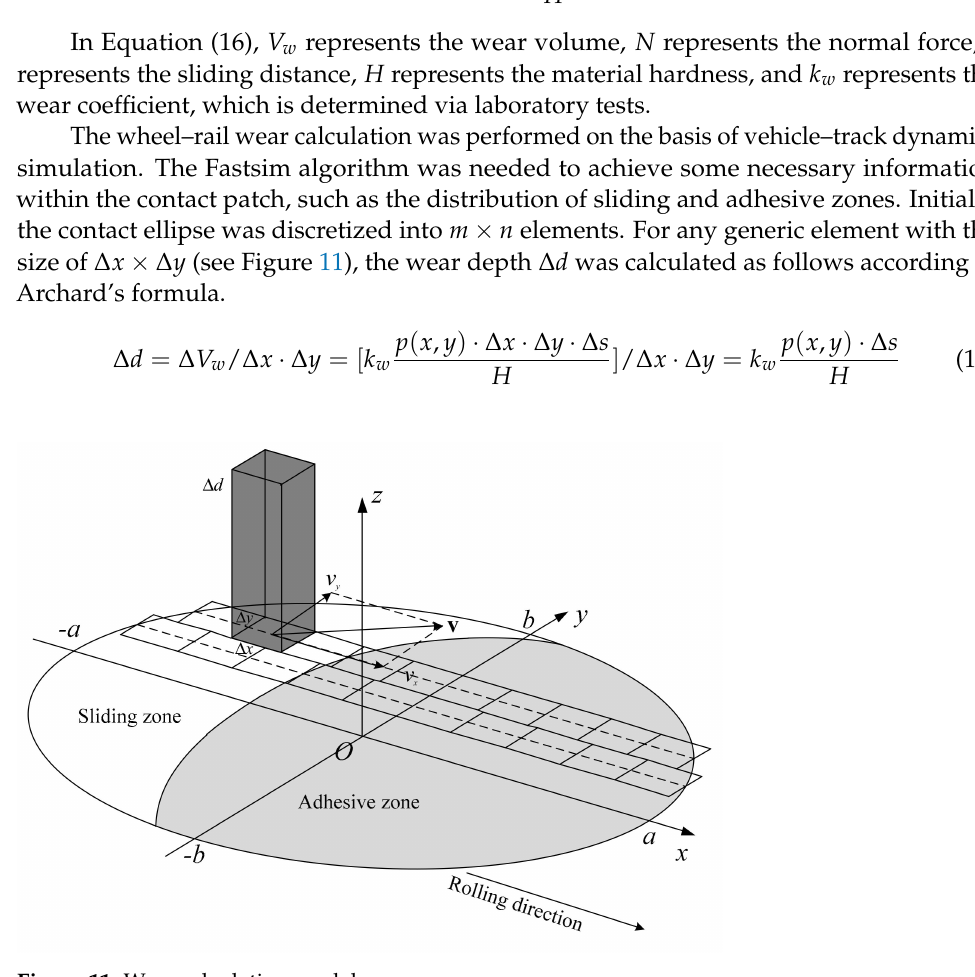
Figure 11. Wear calculation